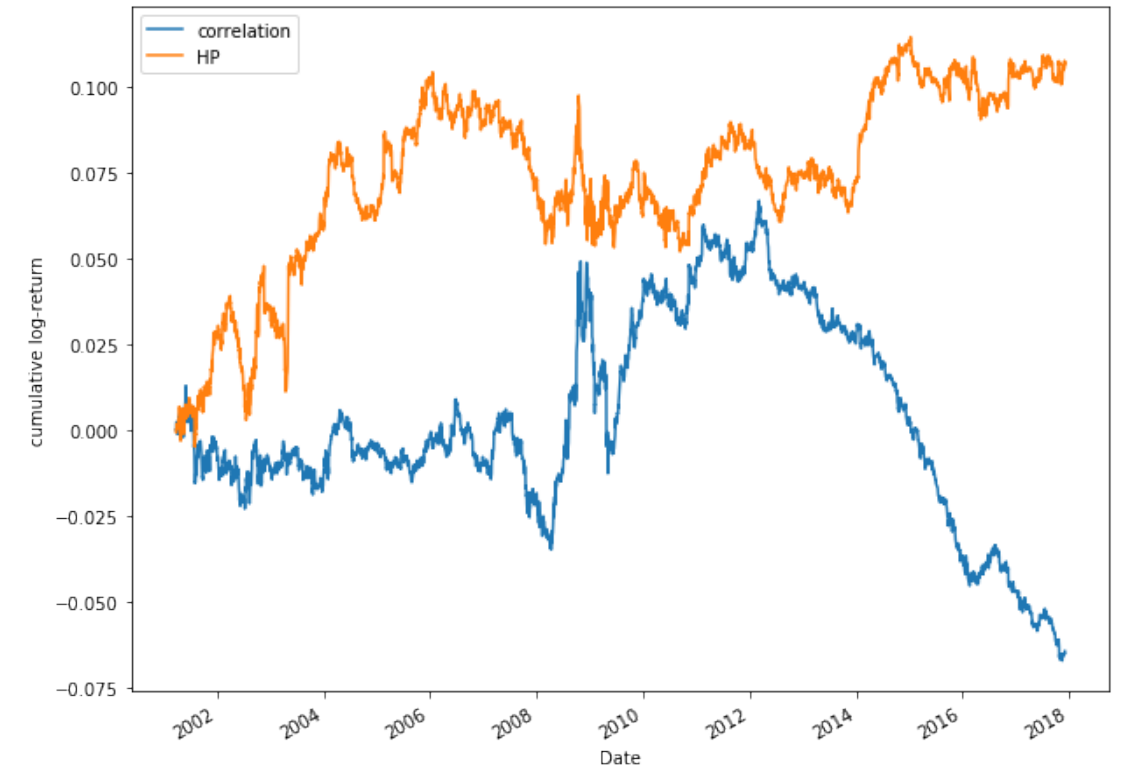
Figure 22. Comparative cumulative log-return of a 25-pair portfolio between HP methods (HP2 version) and Pearson’s correlation coefficient, of Dow Jones securities in the period